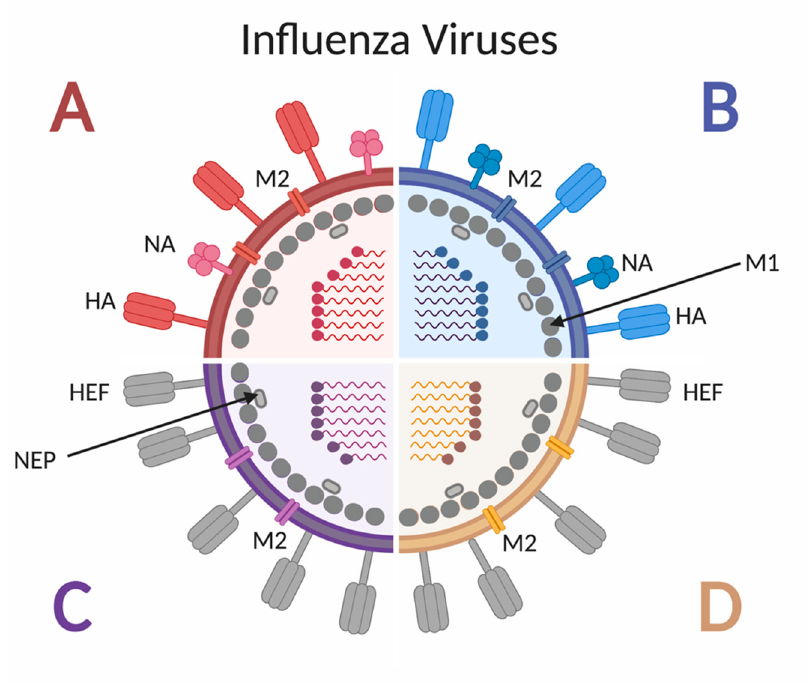
Figure 2. Schematic of influenza A, B, C and D virus structure. Influenza A and B viruses express surface glycoproteins hemagglutinin (HA) and neuraminidase (NA), as well as the M2 ion channel. Both A and B viruses have 8 genomic segments coding for at least 10 proteins. Influenza C and D viruses express the surface glycoprotein hemagglutinin-esterase fusion (HEF), as well as the M2 ion channel. Both C and D viruses have 7 genomic segments coding for 9 proteins. All four types of influenza viruses express the M1 protein along the inner surface on the envelope, adjacent to the nuclear export protein (NEP).